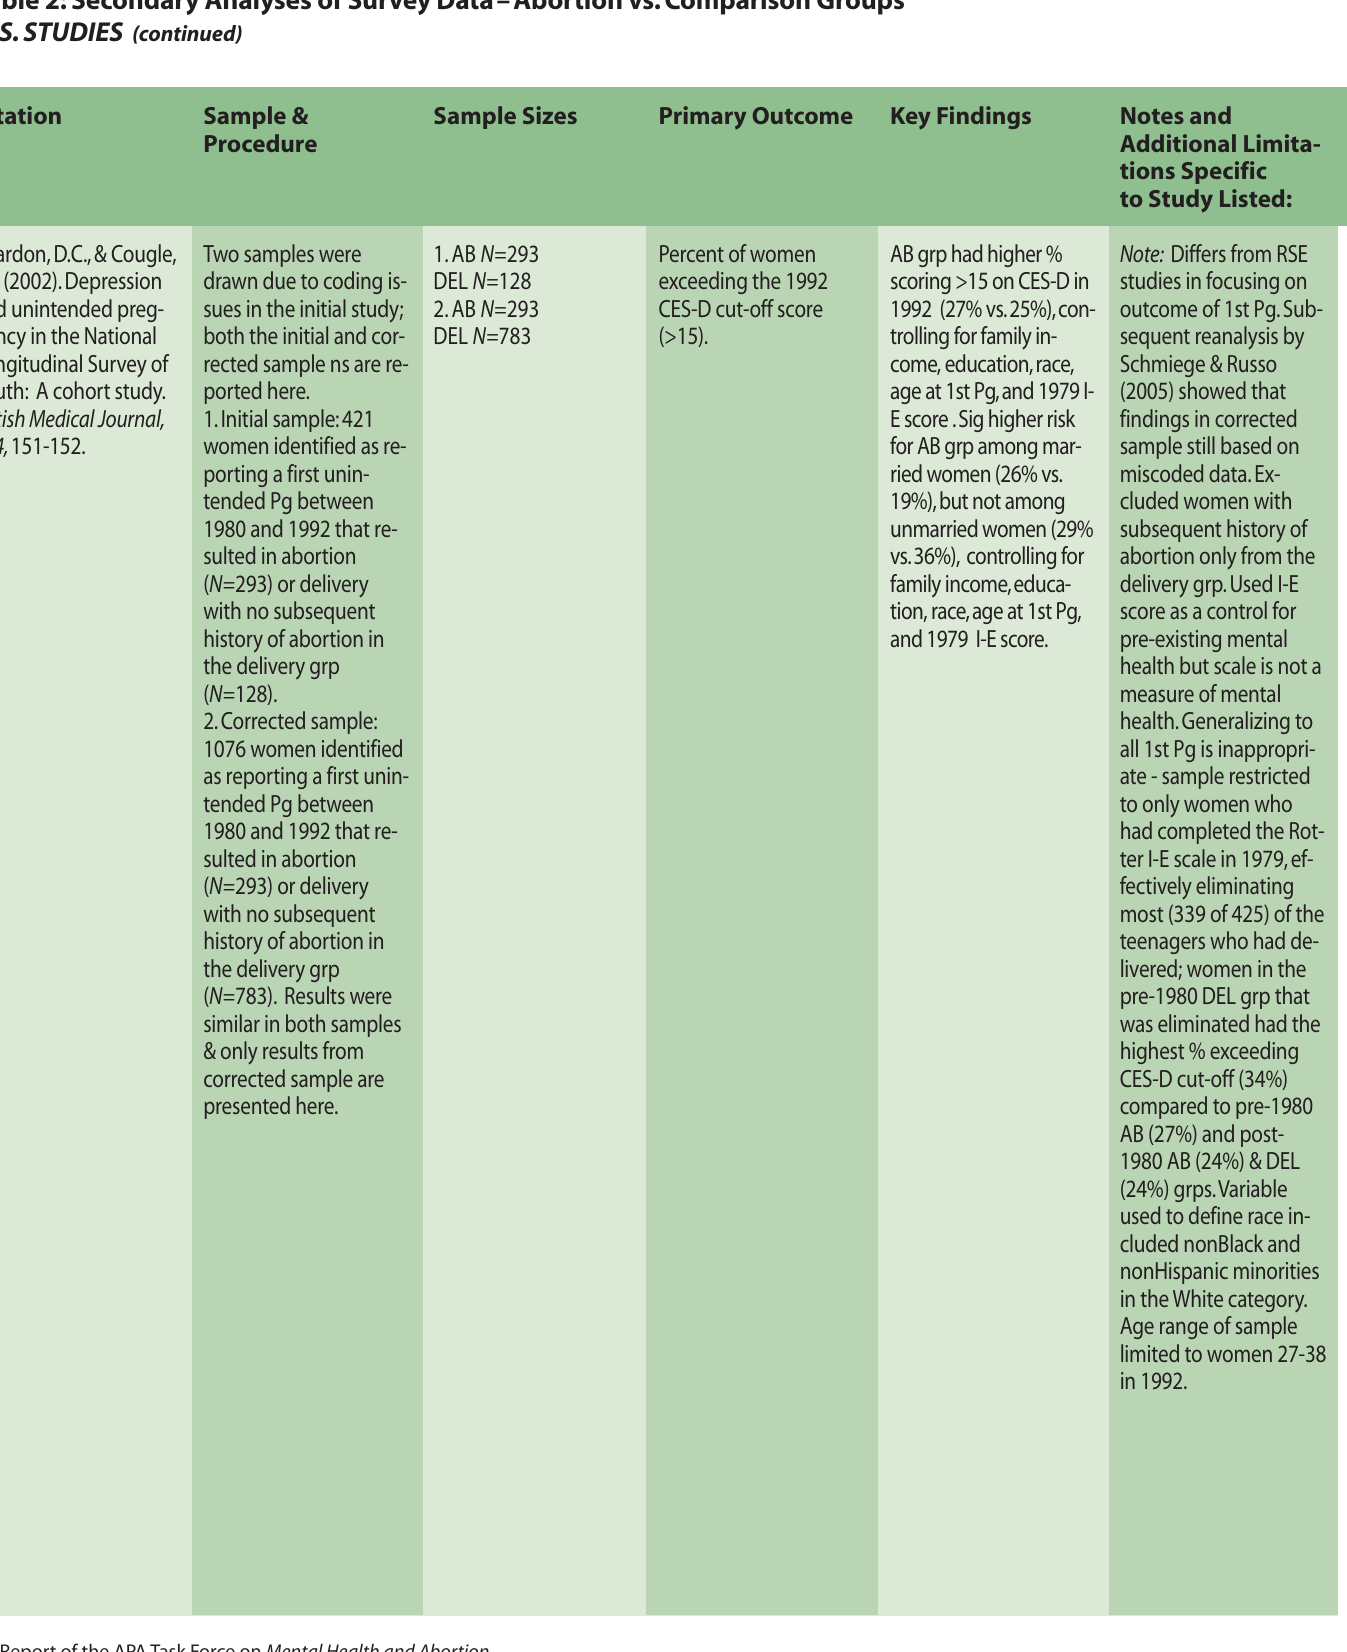
Table 2: Secondary Analyses of Survey Data–Abortion vs.Comparison